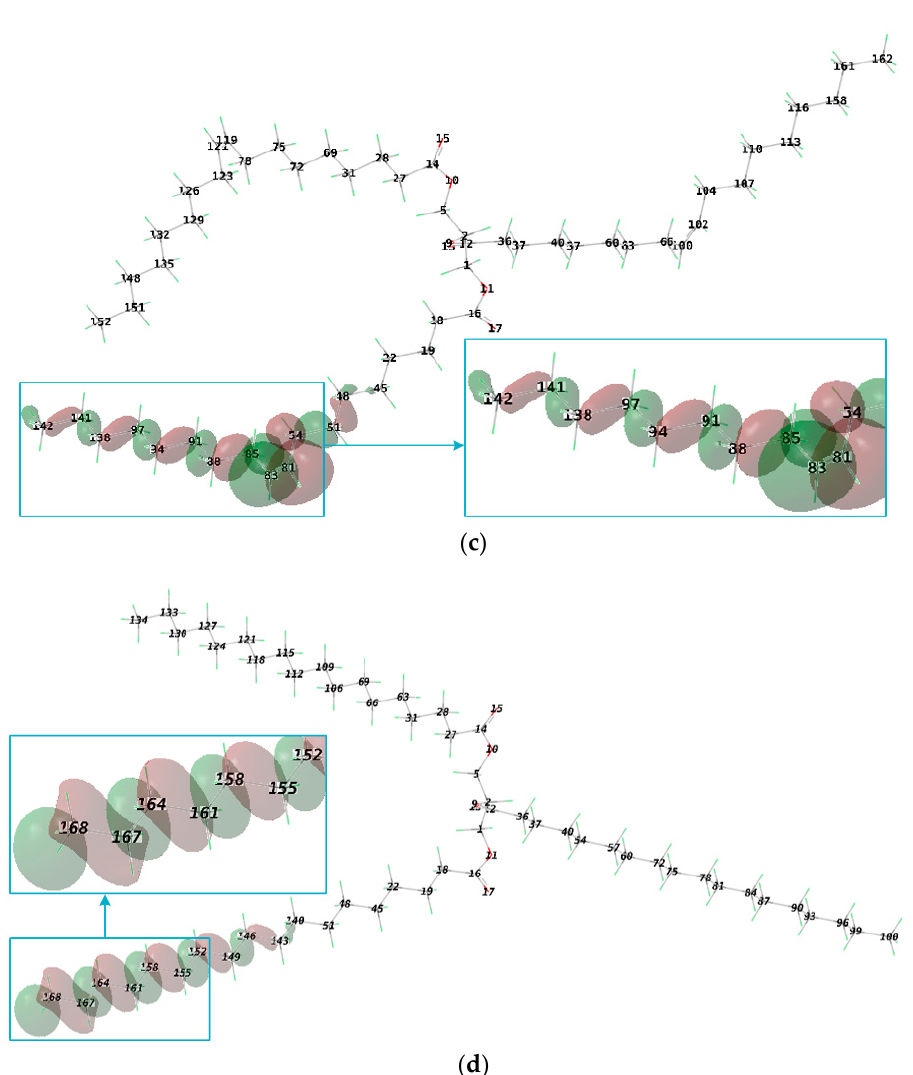
Figure 7. Isosurface of HOMO of molecule under the external electric field along X-axis with the intensity of 2.57 × 10 9 V/m: ( a ) 1-methylnaphthalene; ( b ) eicosane; ( c ) triolein; and ( d ) tristearin.